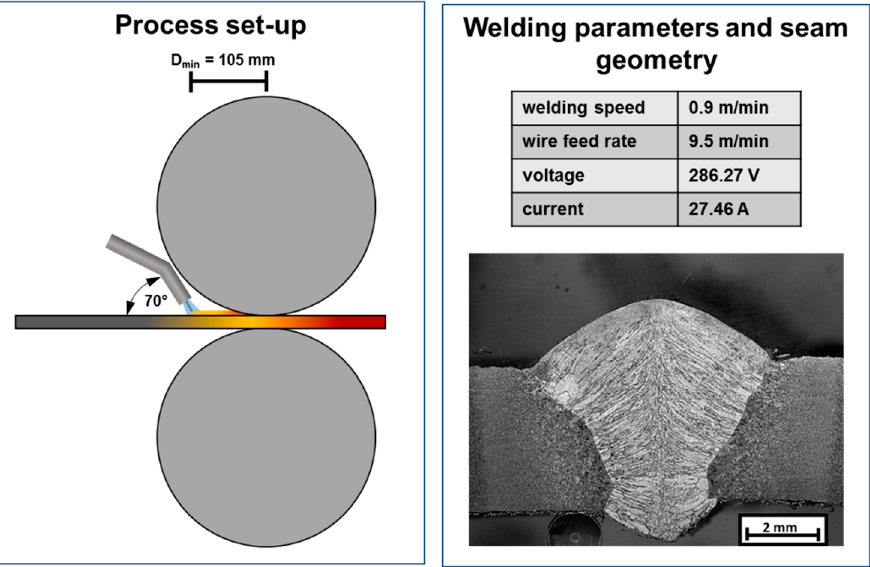
Figure 4. Process set-up for WeldForming (left ) and welding parameters with corresponding cross section of the weld seam without additional rolling ( right ).